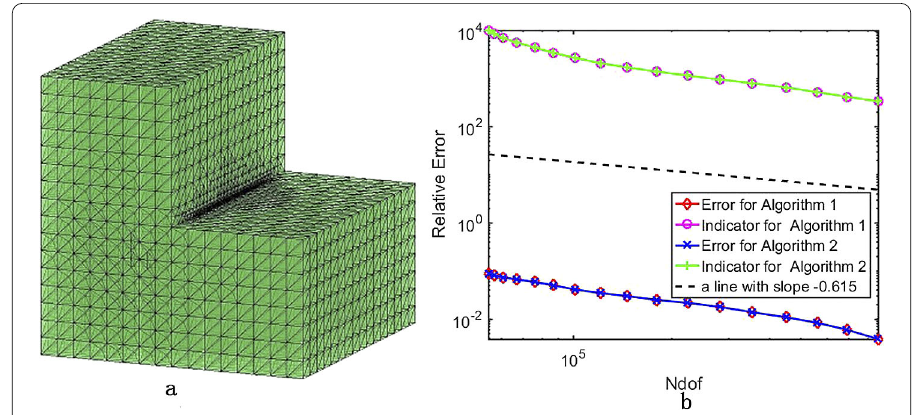
Figure 4 The refined mesh for the L-shaped domain (a) and the convergence rates of the smallest eigenvalue from Algorithm 1 and Algorithm 2(b) in R 3